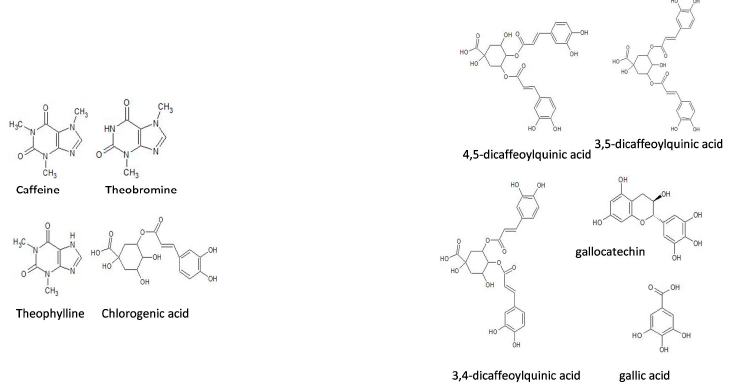
Figure 1. Some of the chemical structures of Ilex paraguariensis components.